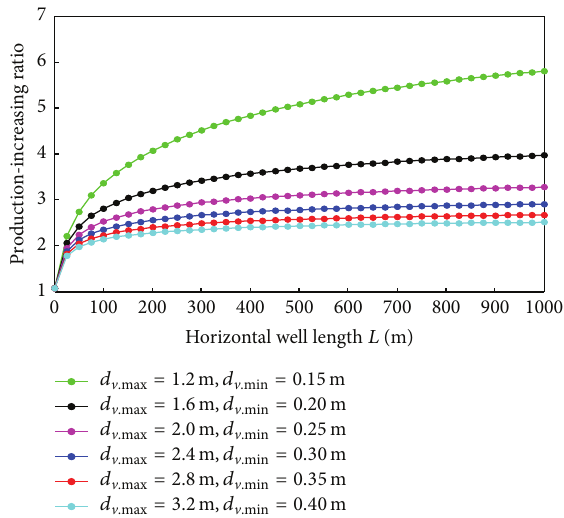
Figure 11: Effect of distance of mud immersion ( 𝑑 V . max , 𝑑 V . min ) on production-increasing ratio ( 𝐿 = 1000 m, 𝑟 𝑤 = 0.1 m, 𝜀 = = 0.56 , 𝜇 = 0.023 mPa ⋅ s, 𝑍 = 0.9 , 𝑇 = 366 K, 0.00016 m, 𝛾 𝑔 𝑔 = 20 MPa, 𝐾 = 0.6 mD, 𝐾 = 0.1 mD, 𝐾 = 1.2 mD, ℎ = 10 m, 𝑝 𝑤𝑓 ℎ V 𝑎ℎ = 0.1 mD, 𝑎 = 1.2 m, and 𝑎 = 0.15 m). 𝐾 𝑑ℎ V . max V . min